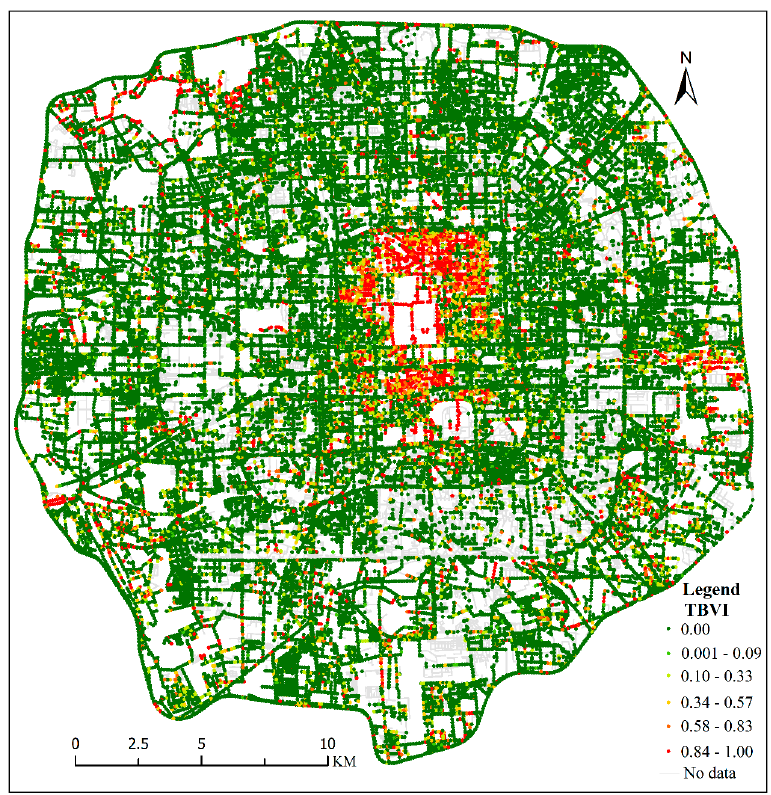
Figure 6. The overall spatial distribution of the traditional building view index (TBVI) of the Chinese traditional-style